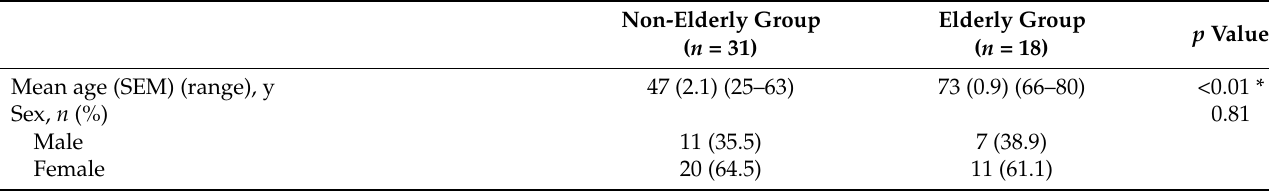
Table 1. Demographic and clinical characteristics of